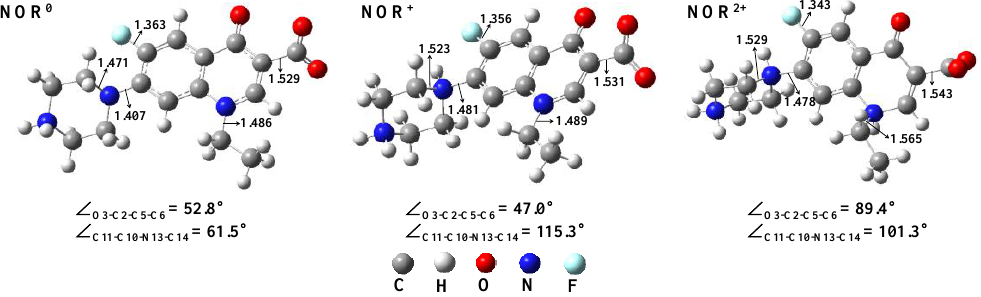
Figure 2. Optimized geometries of three dissociation species of NOR, along with selected bond lengths (Å ) and dihedral angles (°).